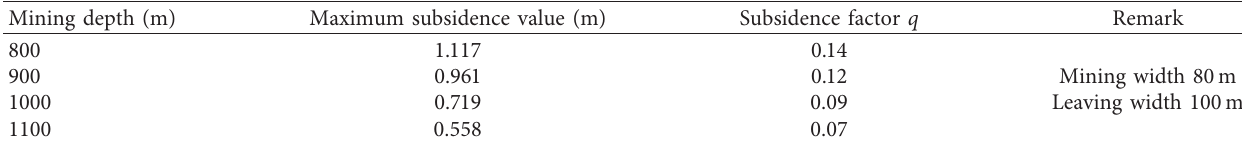
Table 2: Numerical simulation results in different mining depth.